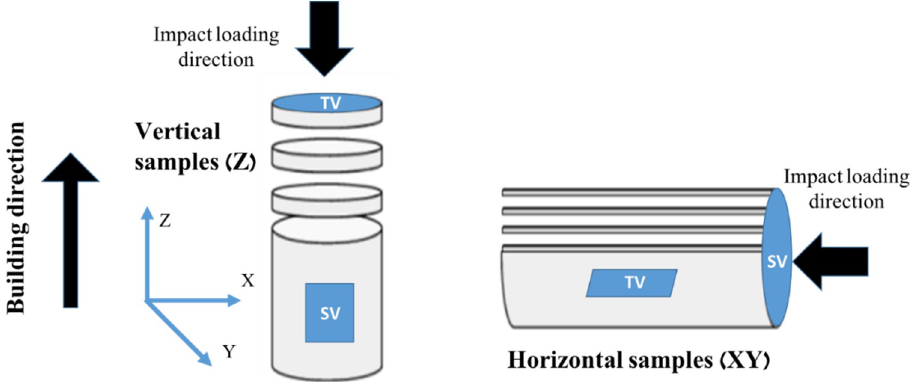
Figure 2. Schematic of vertical and horizontal samples, describing building direction, impact loading direction, and sectioning for microstructural studies. Top view (TV) and side view (SV) denote top view and side view, respectively.